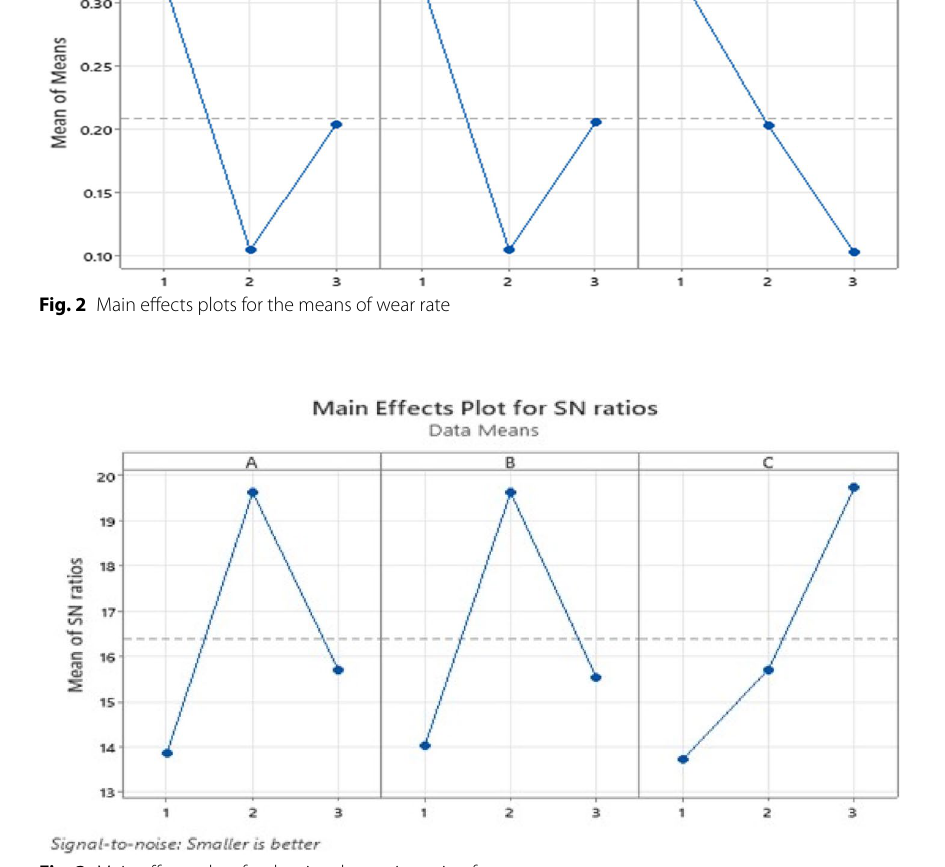
Fig. 3 Main effects plots for the signal-to-noise ratio of wear